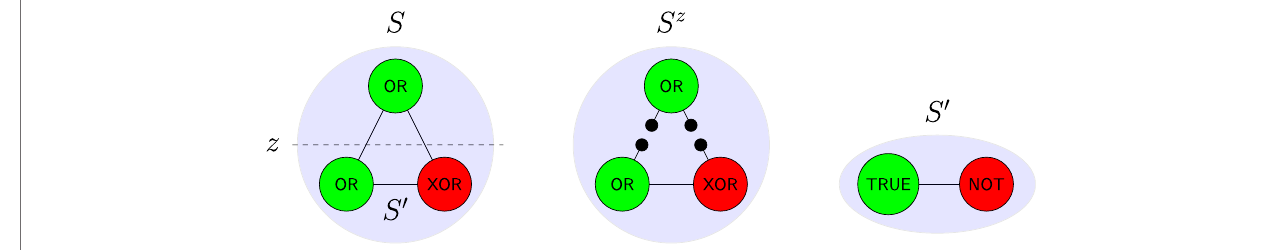
FIGURE 2 | As an example of De fi nition 1 similar to IIT 3.0, consider simple systems given by sets of nodes (or ‘ elements ’ ), with a state assigning each node the state ‘ on ’ (depicted green) or ‘ off ’ (red). Each system comes with a time evolution shown by labelling each node with how its state in the next time-step depends on the states of the others. Decompositions of a system S correspond to binary partition of the nodes, such as z above. The cut system S z is given by modifying the time evolution of S so that the two halves do not interact; in this case all connections between the halves are replaced by sources of noise which send ‘ on ’ or ‘ off ’ with equal likelihood, depicted as black dots above. Given a current state s of S , any subset of the nodes (such as those below the dotted line) determines a subsystem S ′ , with time evolution obtained from that of S by fi xing the nodes in S ∖ S ′ (here, the upper node) to be in the state speci fi ed by s . Note that while in this example any subsystem (subset of S ) determines a decomposition (partition of S ) we do not require such a relationship in